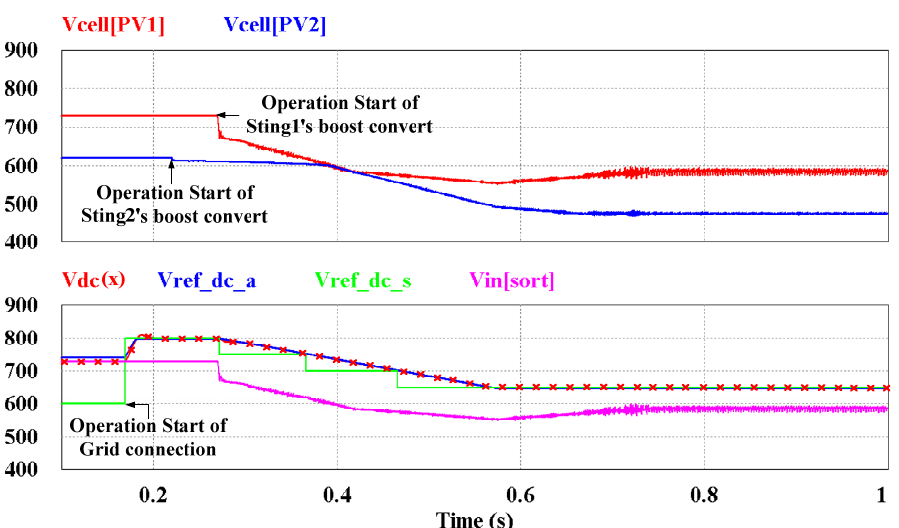
Figure 12. Simulation results for the PV cells voltages, the DC-link voltage, V V , and V sort from Figure 11 when the PV system is ref_dc_a in ,